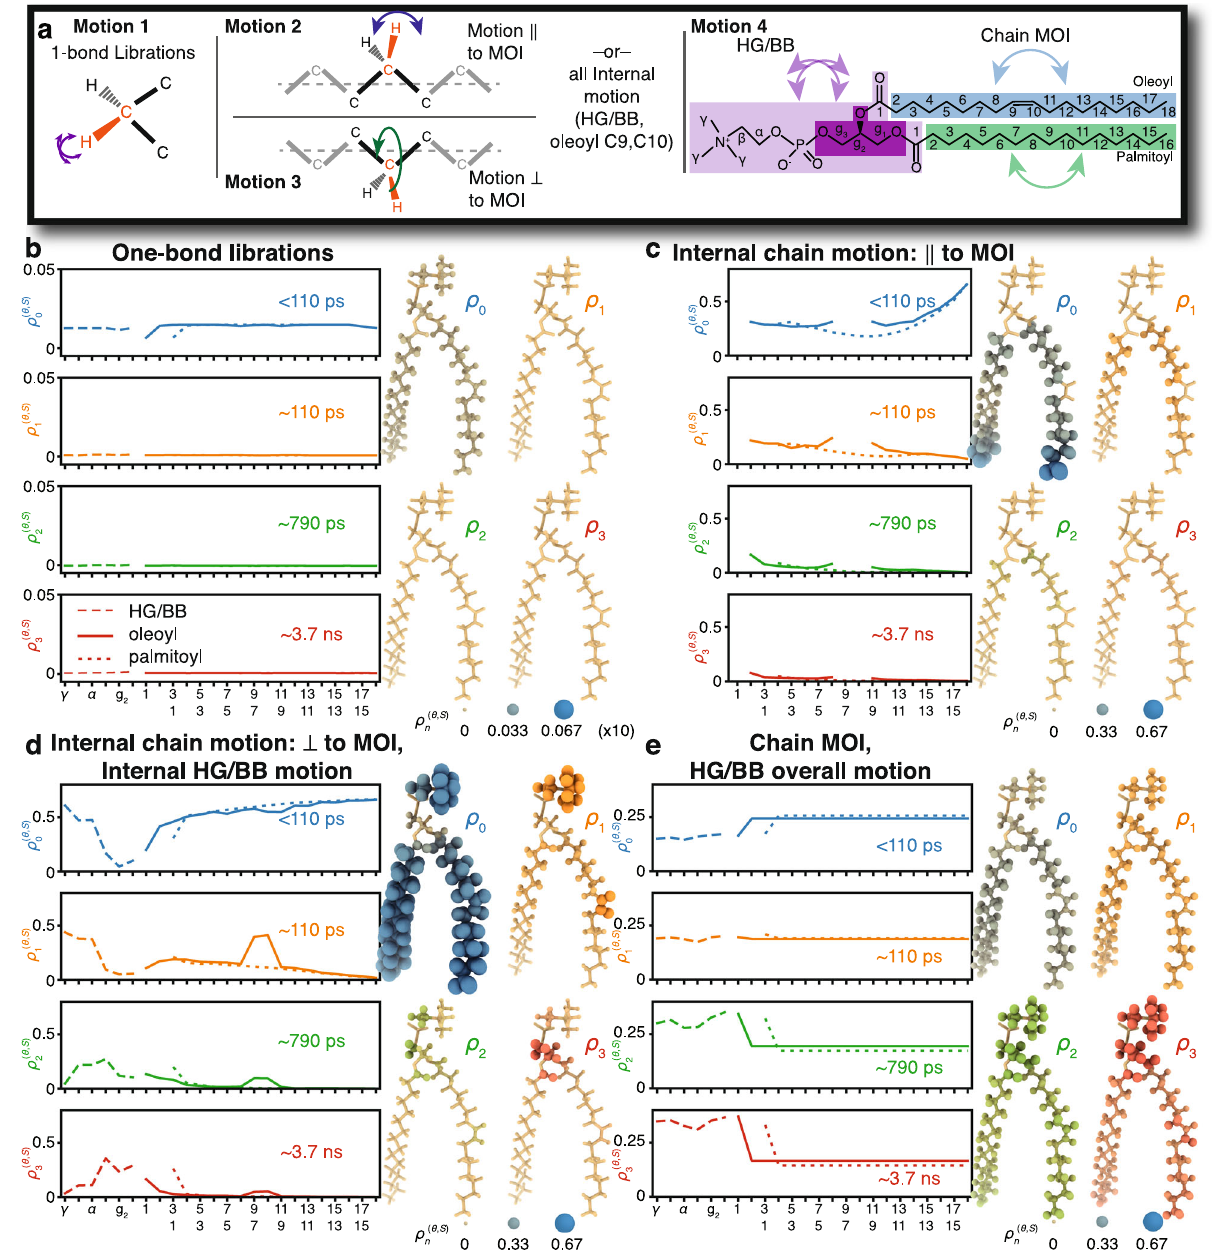
Fig. 4 Detector analysis of individual frames. Panel a illustrates the types of motion captured by the frame analysis: one-bond H – C (or C = O) librations are separated for all sites. Within chains, we separate motion parallel to the moment of inertia (MOI) and perpendicular to the MOI. For the head group, C ′ , and oleoyl carbons 9, 10 (double-bonded), we do not separate internal motion into two components. The overall motion of HG/BB is de fi ned by the alignment of the glycerol atoms to a reference structure, and the overall motion of the chains is de fi ned by the motion of the longest component ( z - component) of each chain ’ s MOI. b – e The detector analysis of the motions of each of the four motions, with detector responses also encoded onto the POPC molecule, where color intensity and radius depend on the detector response (same scale for ( c – e ), scale ×10 in ( b )). For motion not split into perpendicular/parallel components, the internal motion (without libration) is shown in ( d ), with no data shown in ( c ). Source data are provided as a Source Data